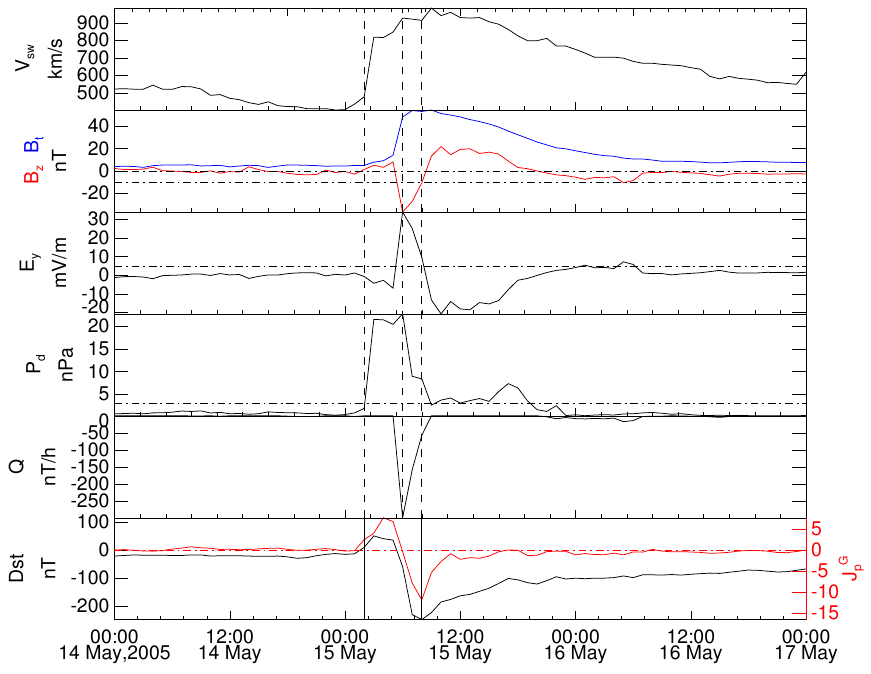
Figure 5. The great magnetic storm event on 15 May 2005. The panels are similar to Figure 4. The vertical lines in the top 5 panels are 02:00 15 May, 06:00 15 May, and 08:00 15 May, respectively. The vertical lines in the bottom panel are 02:00 15 May, and 08:00 15 May, respectively.